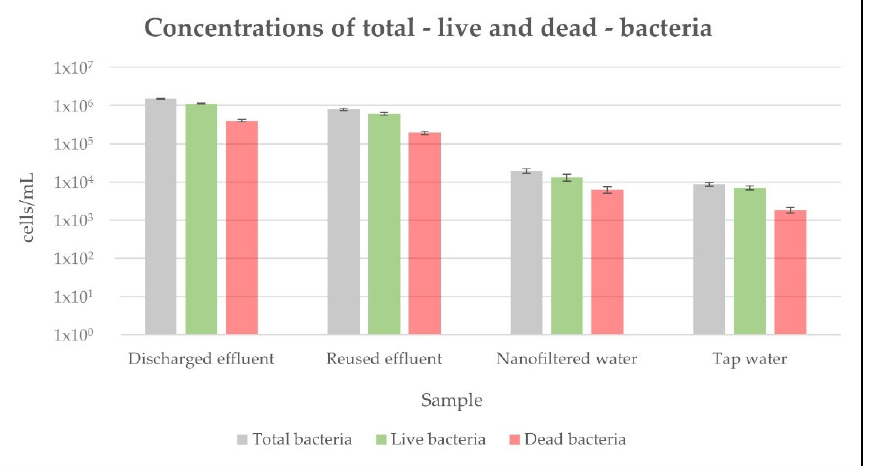
Figure 1. Concentrations of total—live and dead—bacteria in the discharged effluent, reused effluent, nanofiltered water and tap water samples. Values are expressed in cells per milliliter and correspond to the mean ± standard deviation of biological and technical triplicates.